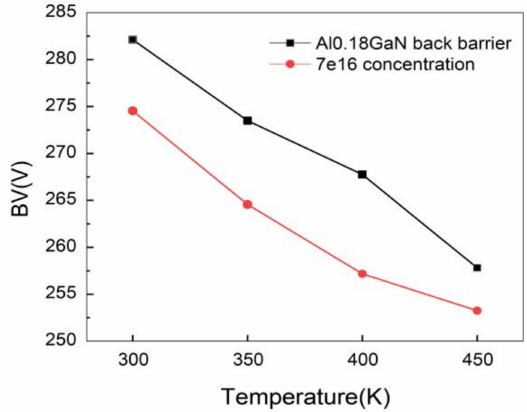
Figure 9. The BV characteristics at different